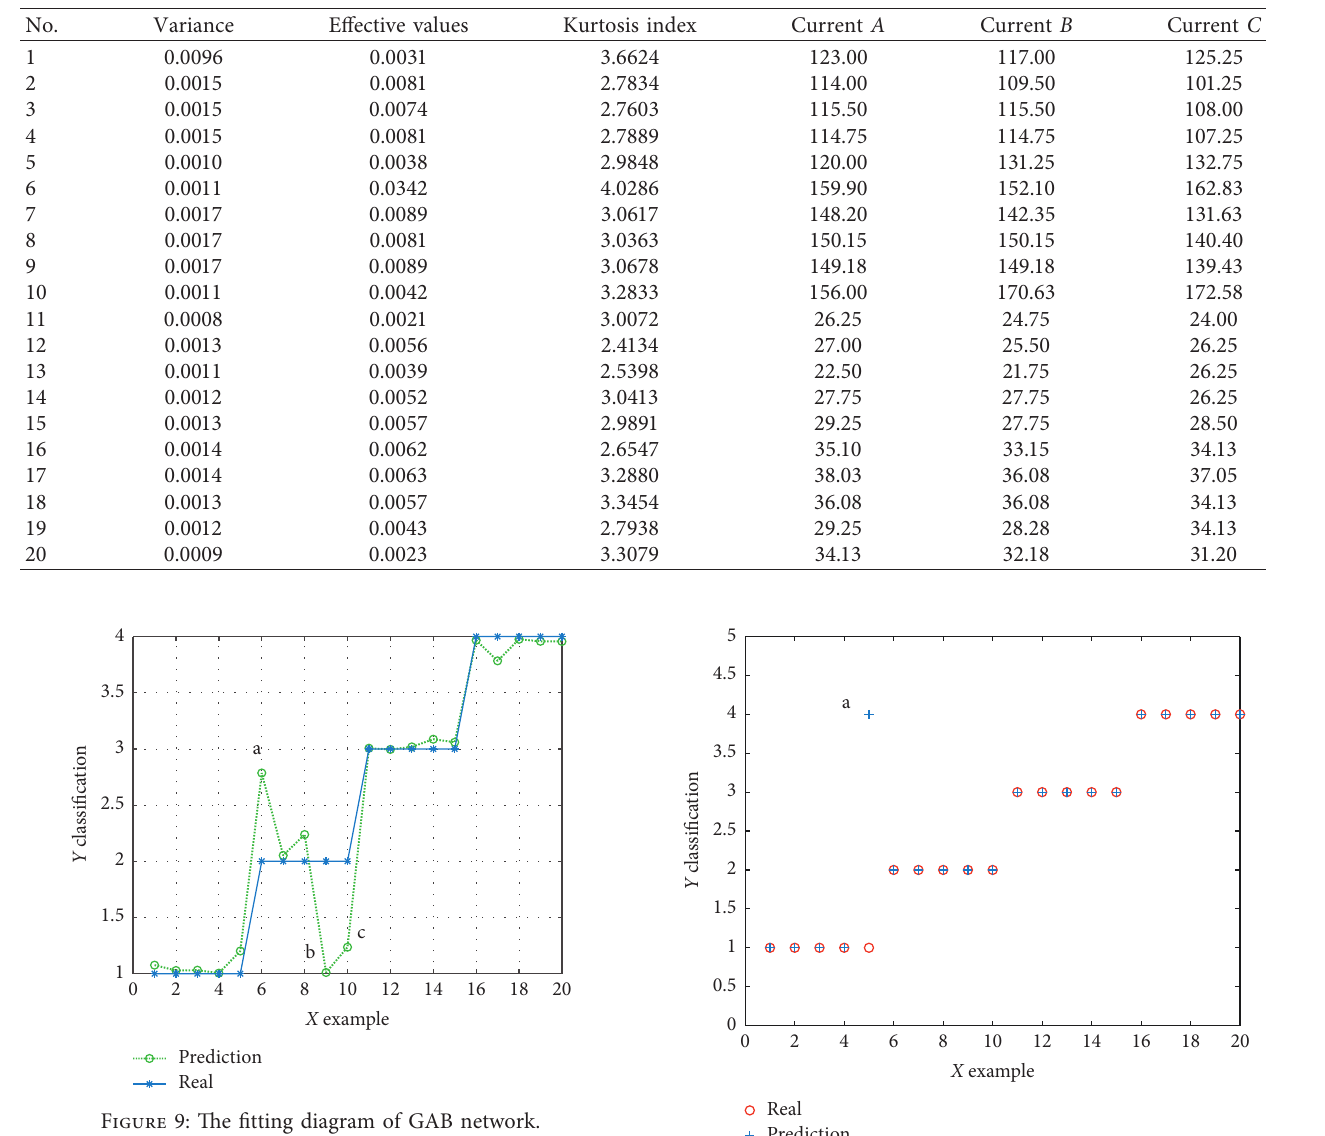
Table 3: Test sample data.